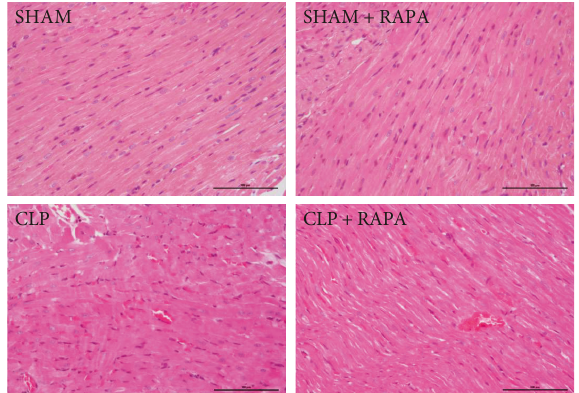
Figure 1: Representative H&E staining of the left ventricle sections. Original magni fi cation, × 200. SHAM, sham operated; CLP, cecal ligation and puncture; RAPA,